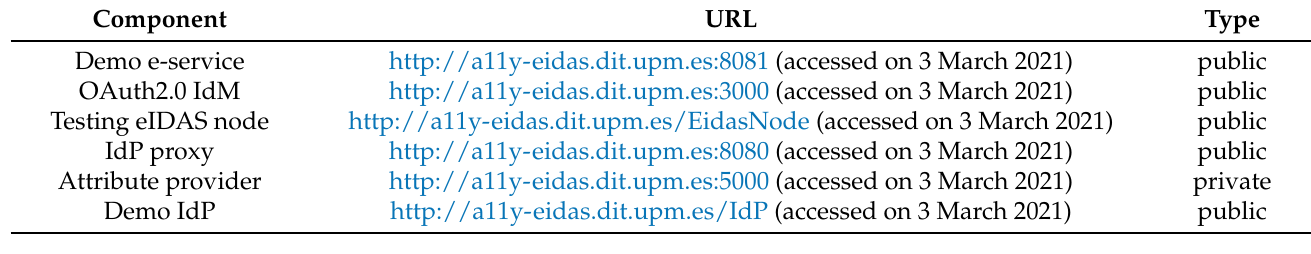
Table 5. Components’ URLs. IdM, Identity Manager.